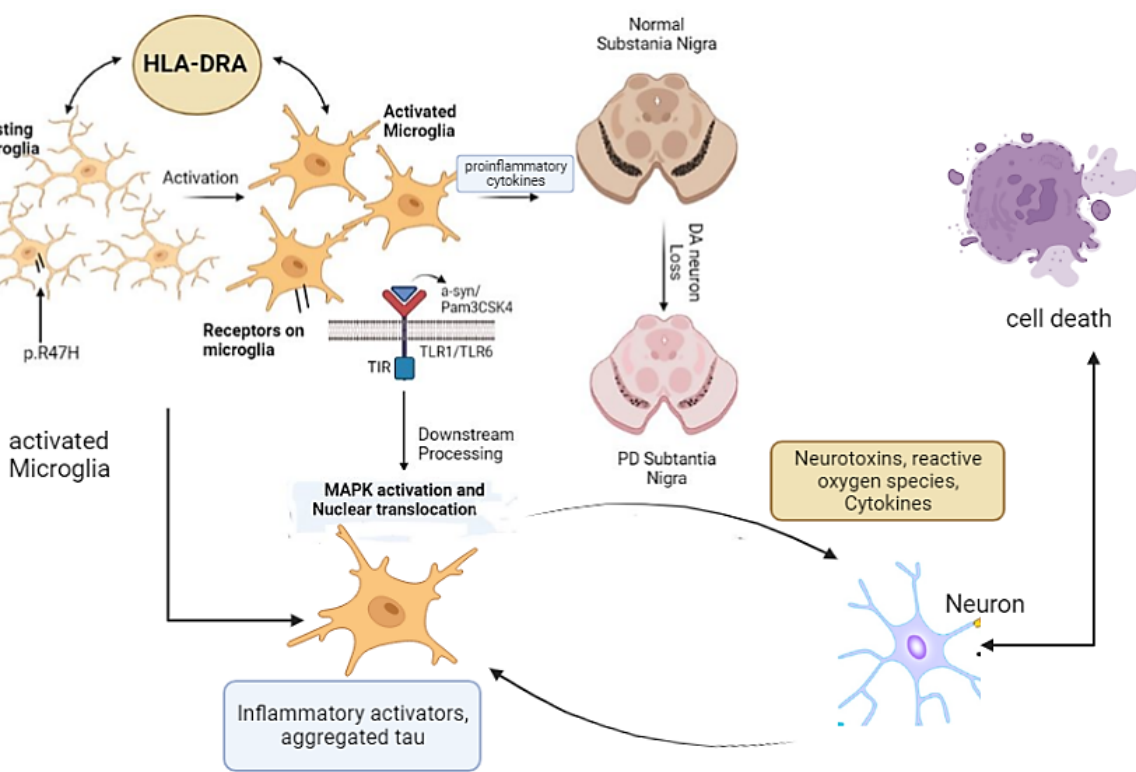
Figure 1. Microglia and microglial receptors in PD. Resting microglia are activated by different stimuli, which ultimately activate MAPK and cell death. Activation of microglia alternatively leads to neuroinflammation and loss of DA neurons and causes PD.